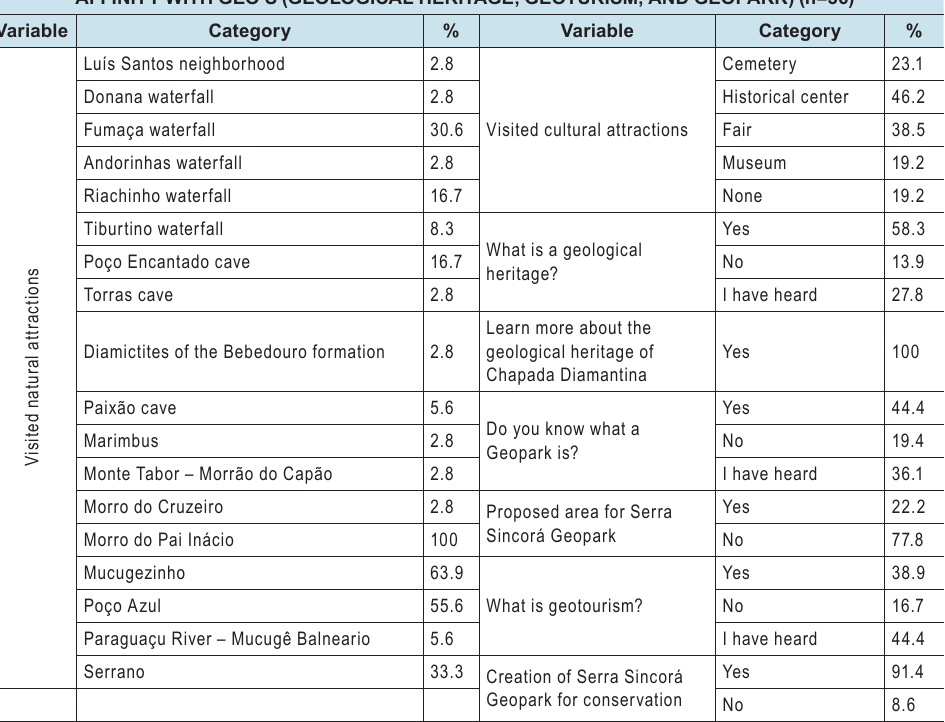
TABLE 4 . Affinity with 3G (geological heritage, geotourism, and geopark) of tourists considered to have a strong affinity for the practice of geotourism in the territory of the Serra do Sincorá Geopark Project, Lençóis, Bahia. AFFINITY WITH GEO’S (GEOLOGICAL HERITAGE, GEOTURISM, AND GEOPARK)